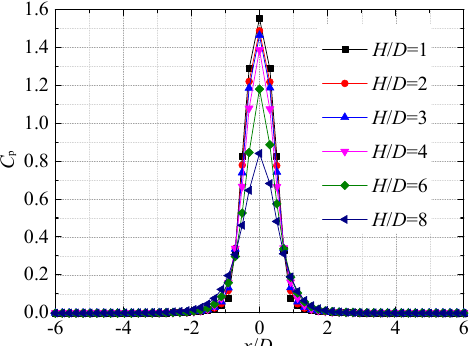
Figure 16. Variation of the pressure coefficient C p along the x axis in the flow direction.